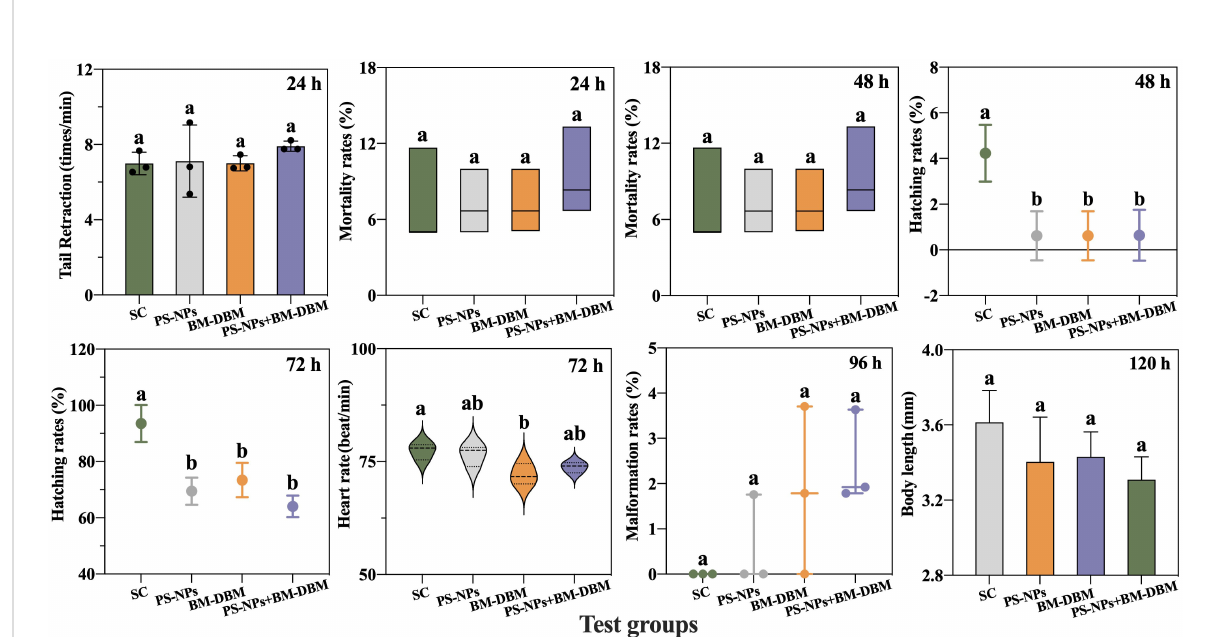
FIGURE 2 Response of growth and development indicators. SC represents the solvent control group. Groups that did not contain the same letter were signi fi cantly different (P <